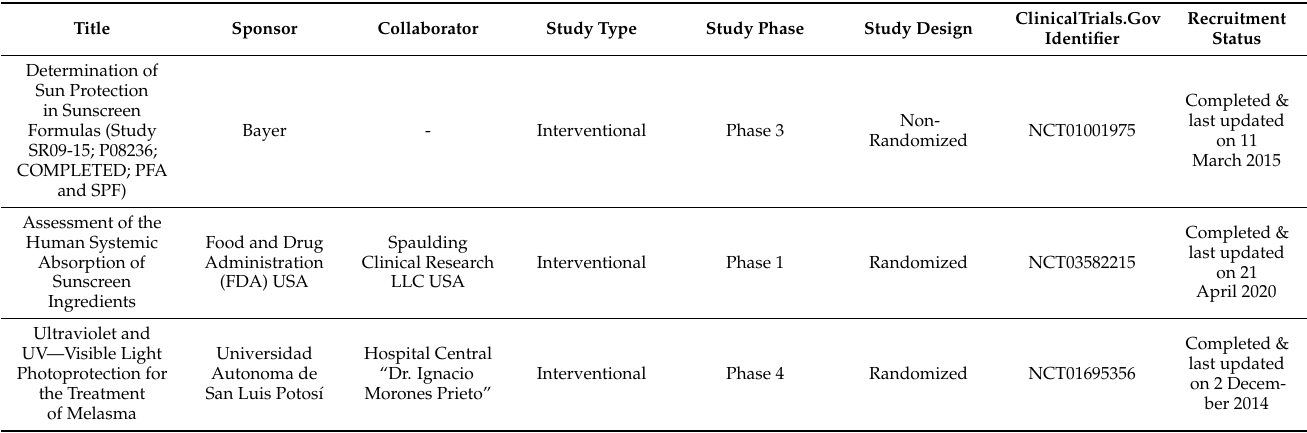
Table 3. Clinical trial details for